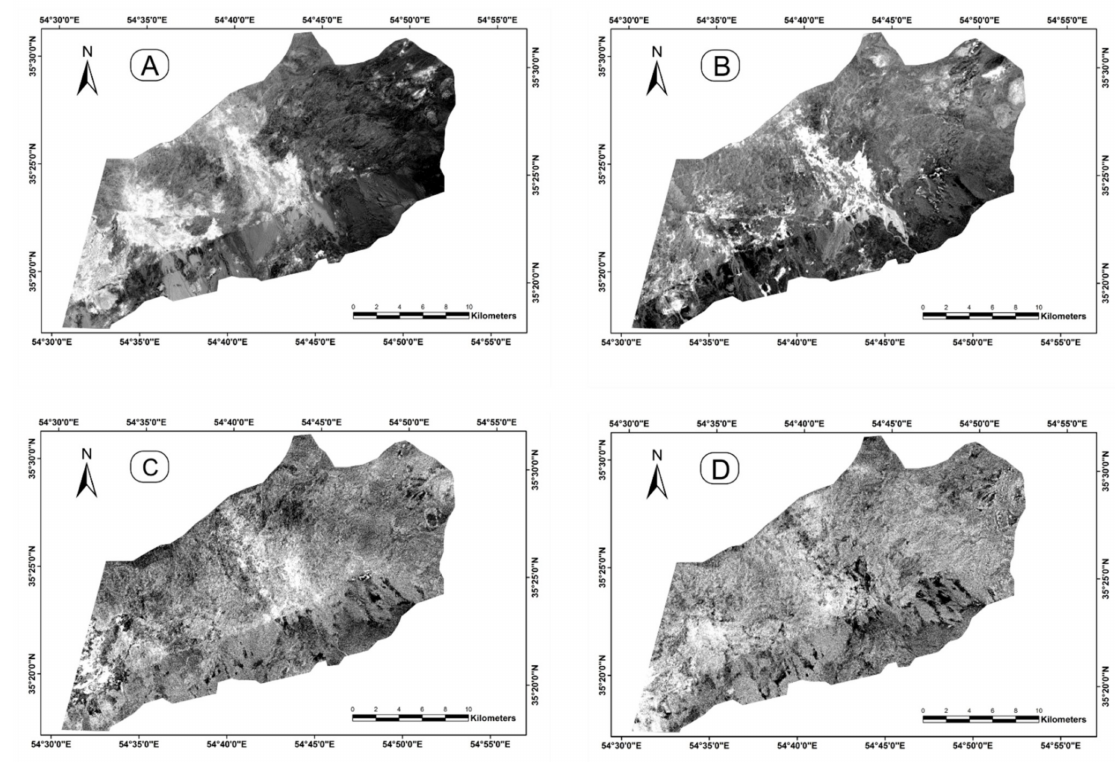
Figure 4. SPC images derived from SPCA analysis. ( A ) SPC2 image showing oxide/hydroxide minerals as bright pixels; ( B ) SPC3 image showing the argillic alteration zone as bright pixels; ( C ) SPC3 image showing the phyllic alteration zone as bright pixels; and ( D ) SPC3 image showing the propylitic alteration zone as bright pixels.